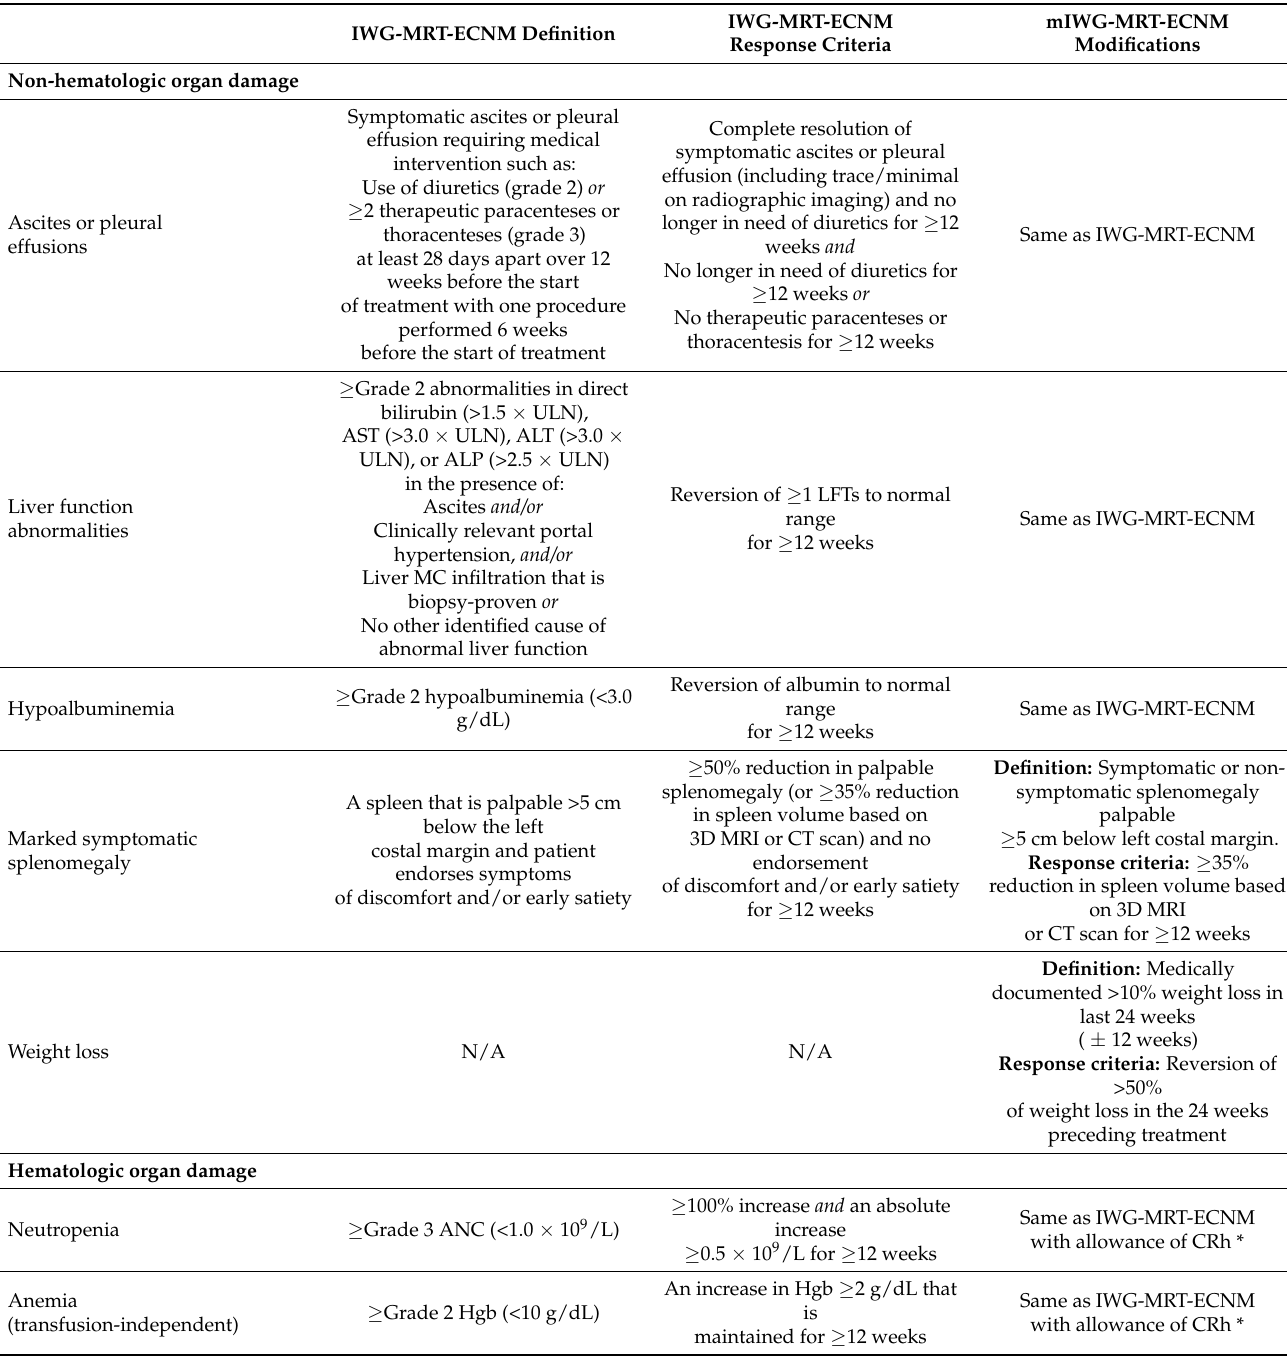
Table 3. IWG-MRT-ECNM and Modified IWG-MRT-ECNM definitions of evaluable organ damage and